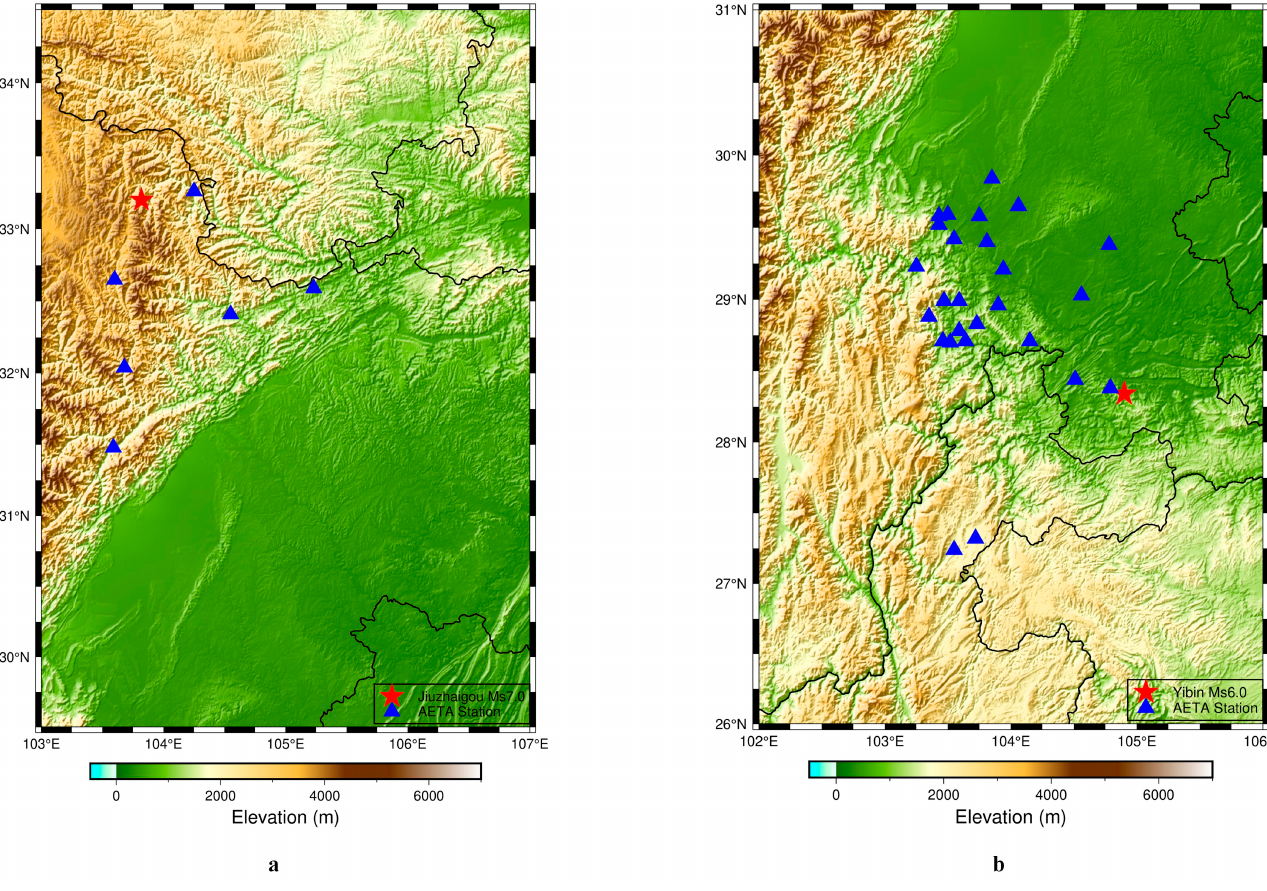
Figure 7. The epicenter of two major earthquakes and nearby stations. ( a ) Jiuzhaigou M. 7.0; ( b ) Yibin M. 6.0. Table 1. AETA Station within 200 km of the Jiuzhaigou